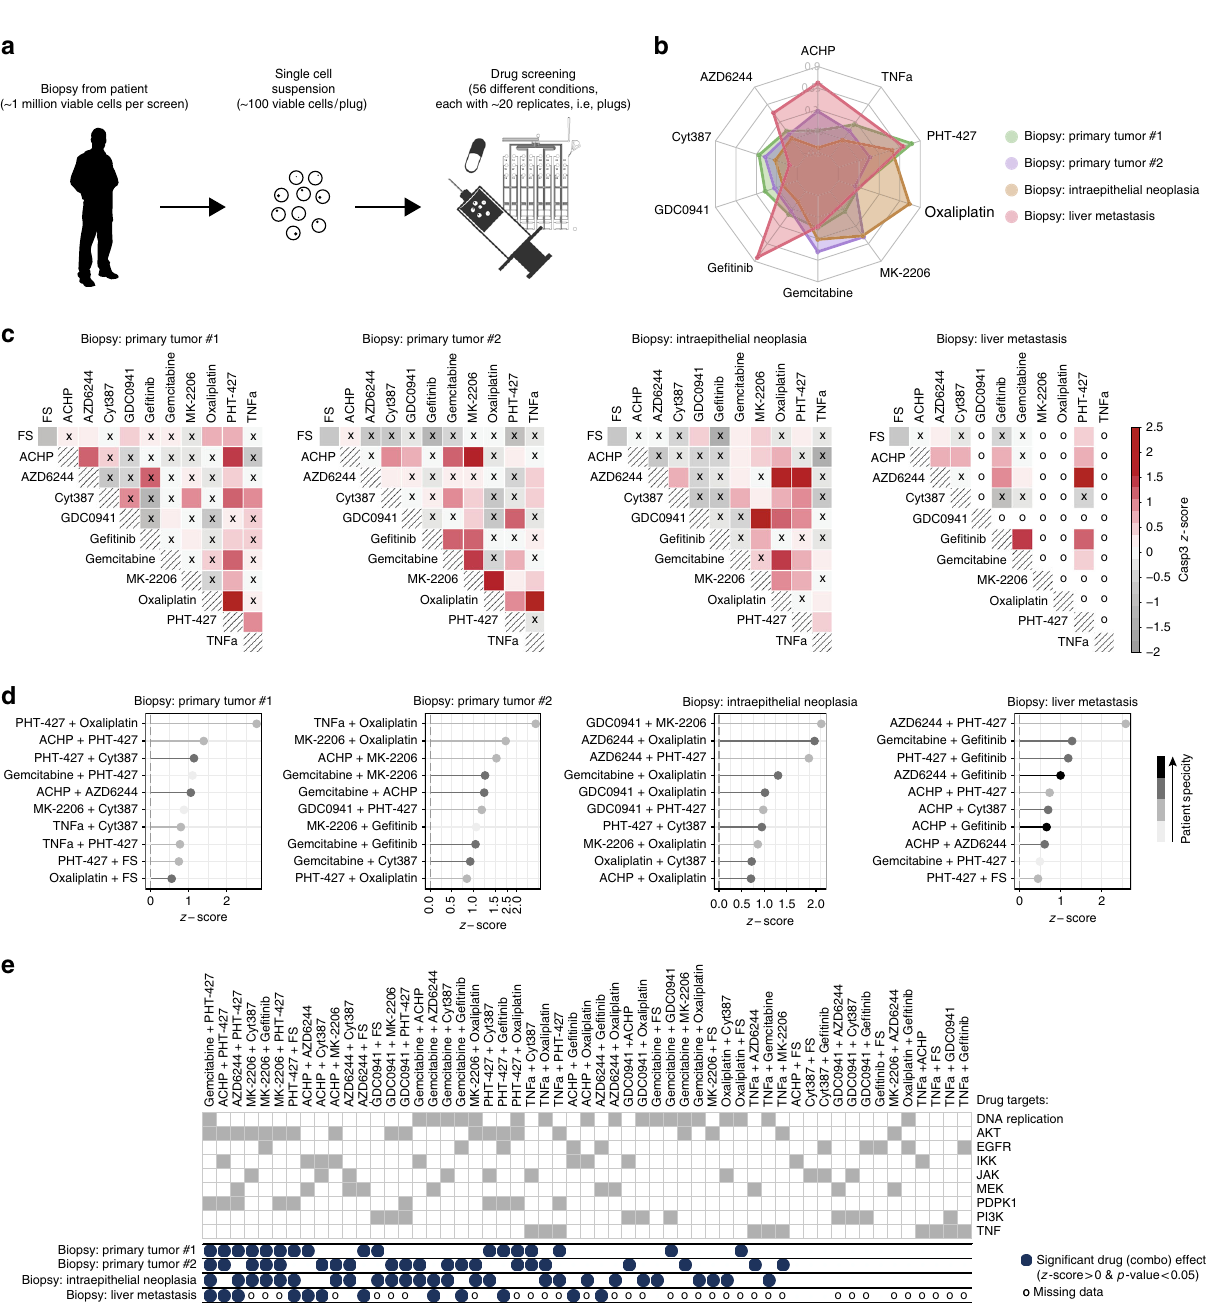
primary tumor #1 Biopsy: primary tumor #2 Biopsy: intraepithelial neoplasia Biopsy: liver metastasis Fig. 6 Micro fl uidic combinatorial drug screening of patient biopsies. a Work fl ow for patient samples. Functional drug screening on biopsies from human patients: each biopsy is dissociated to a single cell suspension, which is perturbed with different compounds using the micro fl uidics platform. b Overall drug ef fi cacy for each cell line, computed as median z -score across all conditions (single or combinatorial perturbations) involving the drug. c Heatmap representation of ef fi cacy of single and combinatorial drug perturbations for each patient using colored red scale starting from z-score equal to 0 (i.e., median activation across all conditions) while negative values are represented in grey. Conditions which are not signi fi cantly better than the control are marked with an x. The corresponding cell in the matrix is marked with ‘ o ’ in case of unmeasured conditions (two of the 10 drugs were not screened for the biopsy of liver metastasis) or technical issues (e.g., conditions with plugs showing unexpected dilutions of the orange marker dye added to the cell suspension). d Top 10 most effective drugs or combinations for each patient. Grey scale is used to map the speci fi city of each combination with light grey representing very unspeci fi c conditions (i.e., effective in all patients where the condition was tested) and black representing highly speci fi c conditions (effective only in one patient). e Comparison of ef fi cacy of different patient samples to all perturbations with drug combinations ordered from left to right based on the number of patient samples in which they are effective. Drug targets are also shown in dark